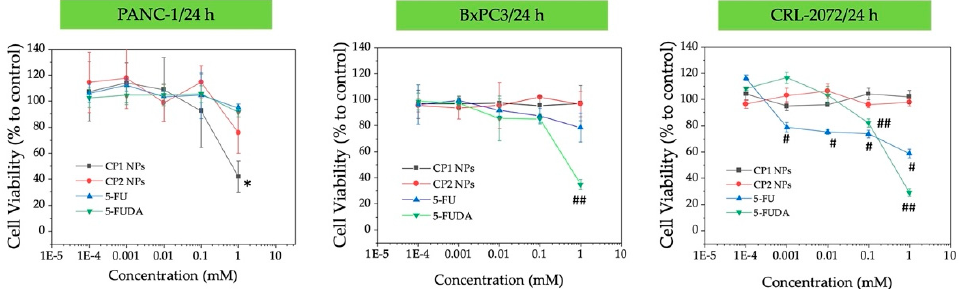
Figure 3. Cell viability of PANC ‐ 1, BxPC3, and CRL ‐ 2072 cells treated with CP1 and CP2 NPs, 5 ‐ FU , and 5 ‐ FUDA at different doses (from 0.0001 mM to 1 mM) after 24 h of incubation time. Values represent means of three to six replicates ± SD of one representative experiment. * p < 0.05, CP1 NPs group. # p < 0.05, 5 ‐ FU group. ## p < 0.05, 5 ‐ FUDA group.